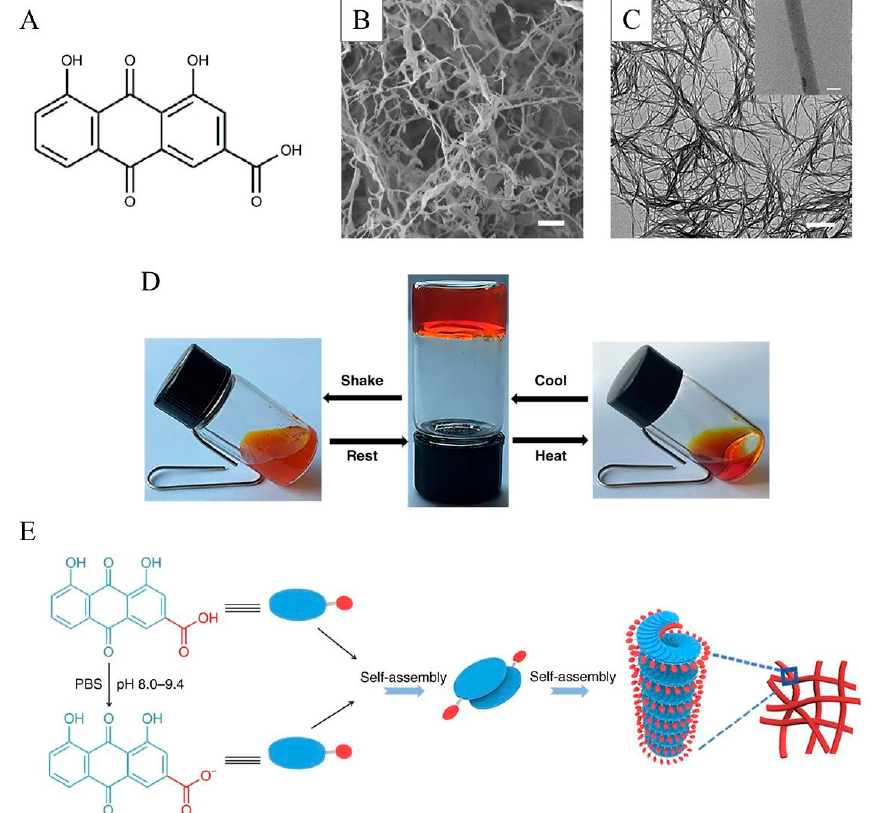
Figure 4. Schematic illustration of the rhein-based hydrogel: ( A ) Chemical structure of rhein; ( B ) SEM image of the rhein hydrogel; ( C ) TEM image of the rhein hydrogel; ( D ) Reversible sol–gel transitions of rhein-based hydrogel triggered by shear stress and temperature; ( E ) Self-assembly mechanism of the rhein-based hydrogel. Reproduced with permission from Copyright (2019) Nature Publishing Group.